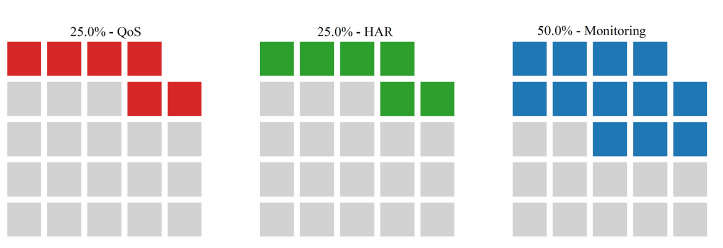
Figure 26. Main challenges in logistics addressed by the papers included in the